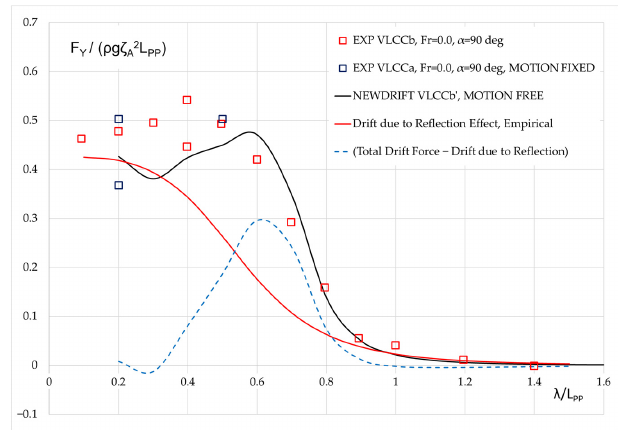
Figure 11. Various components of the mean sway force of a ship in regular beam waves, Fr = 0.0.